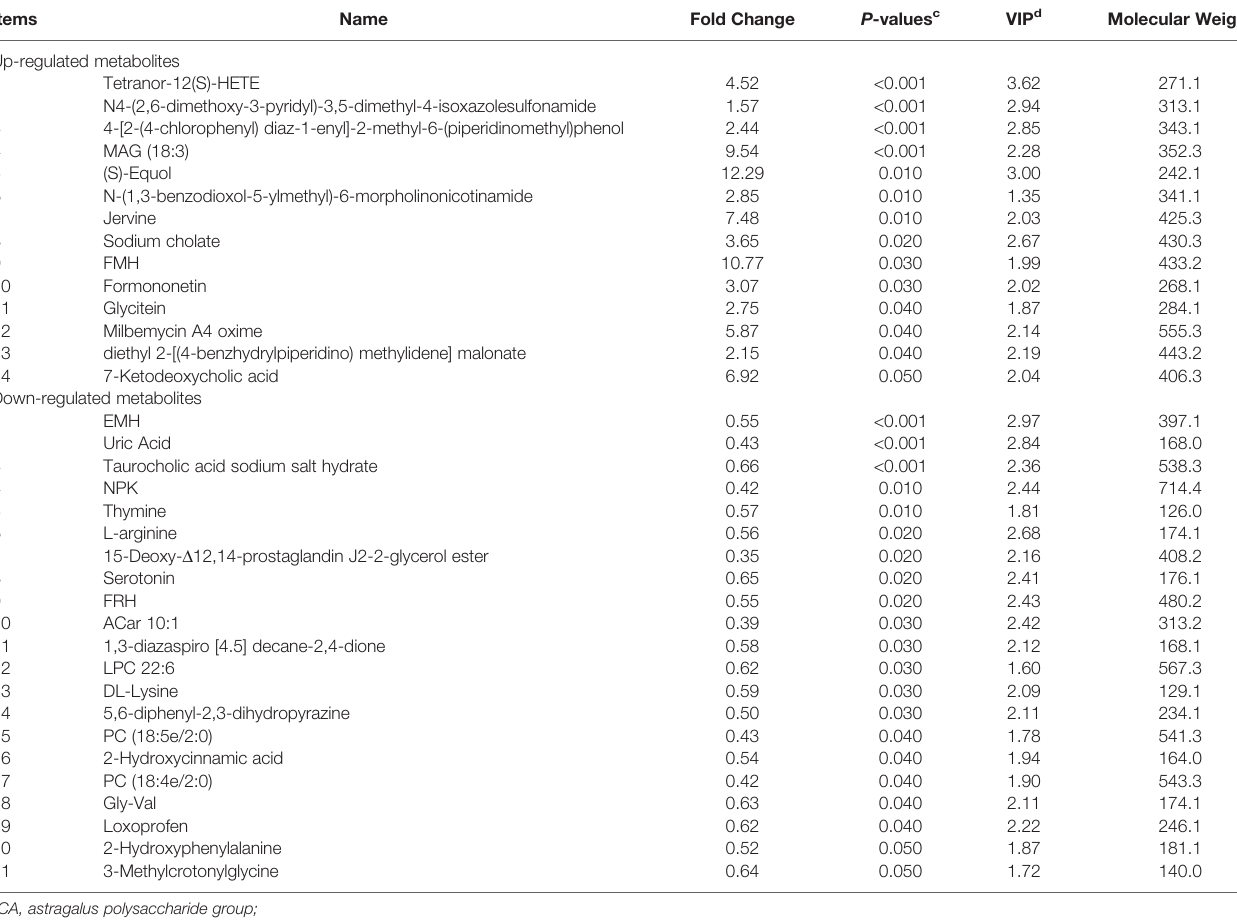
TABLE 3 | Up-regulated and down-regulated metabolites in ileum from group CA a vs CC b (Positive ions). Items Name Fold Change VIP